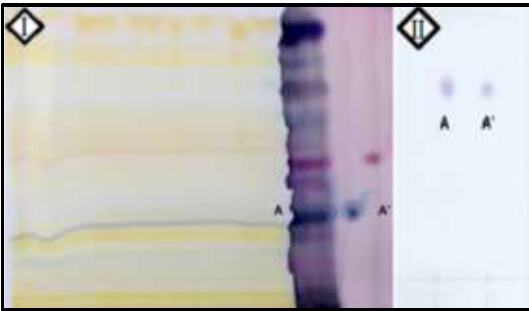
Figure 3. Isolation and purity confirmation of C1 from hexane extract: (I) PLC plate for isolation using MP2, (II) TLC plate for purity confirmation using MP4, (A)C1 spot, (A') standard beta-sitosterol spot.